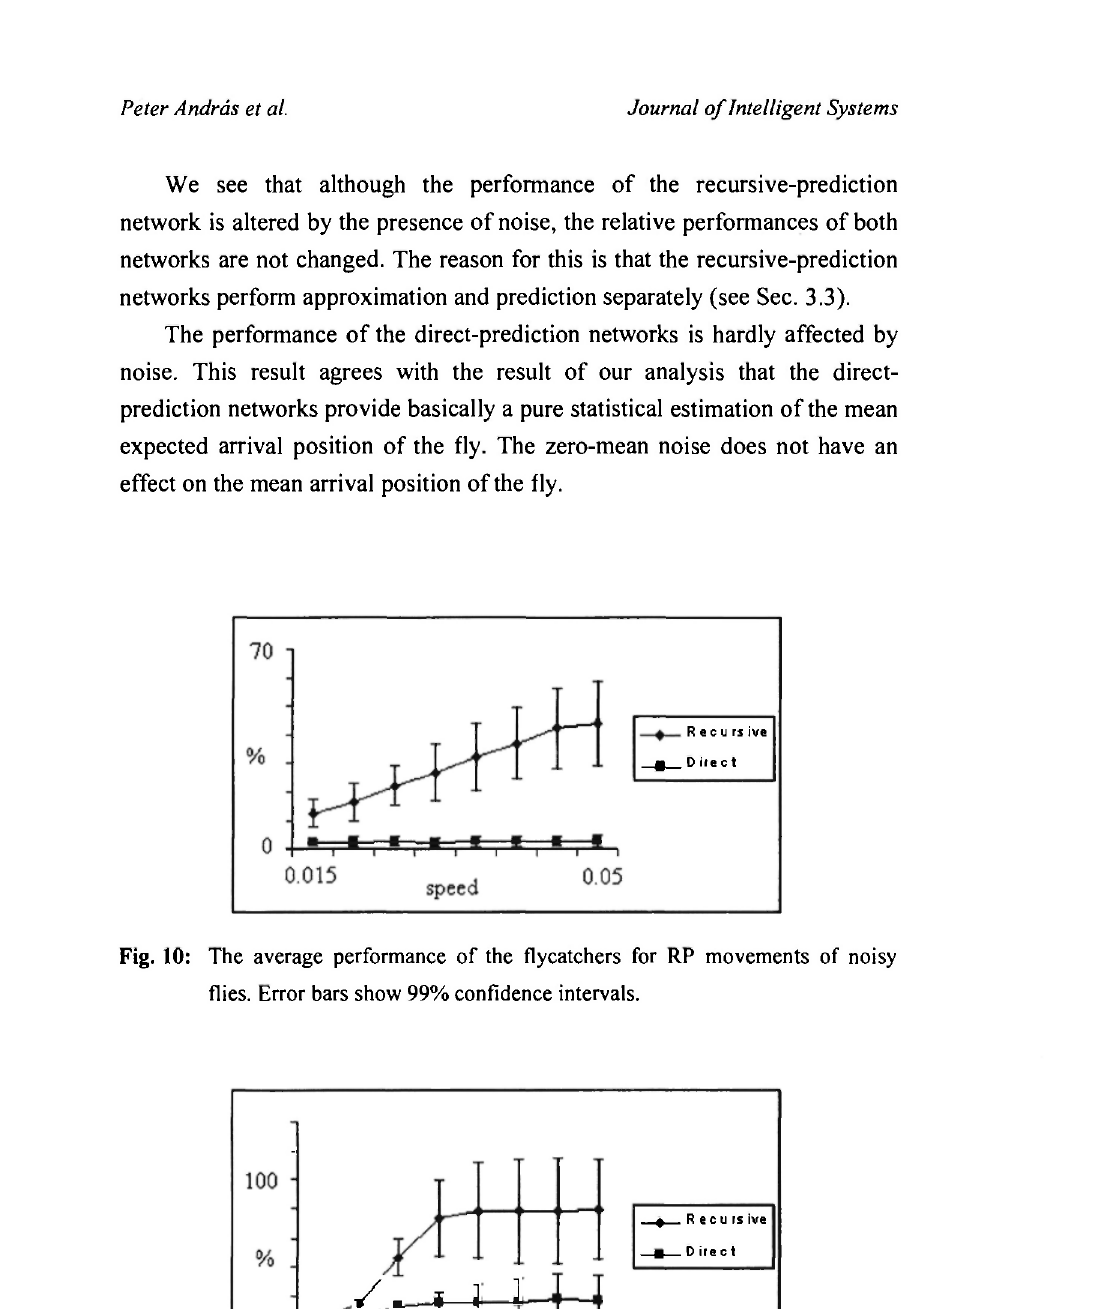
Fig. 11 : The average performance of the flycatchers for RW movements. Error bars show 99% confidence